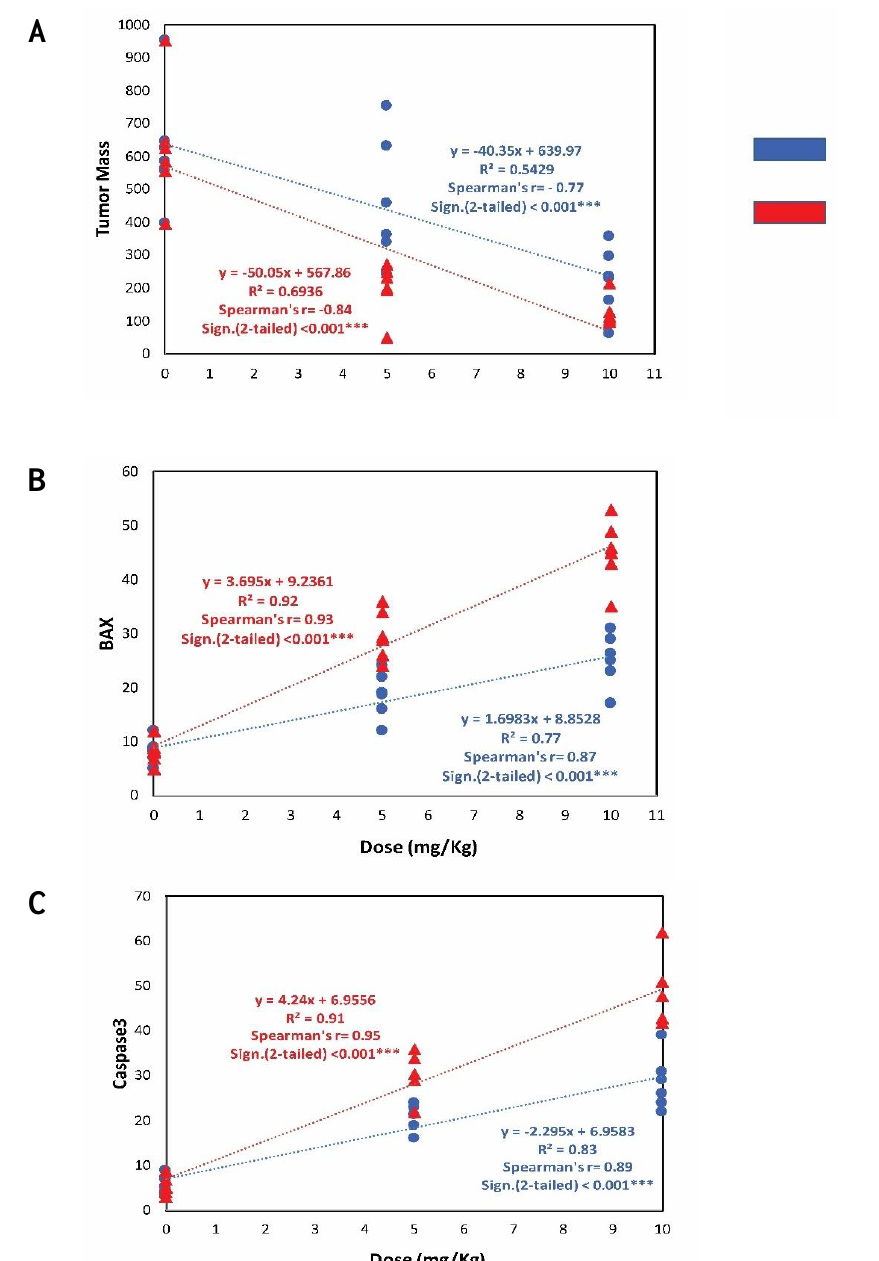
Figure 9. Regression trend-line for correlation between the drug preparations and tumor markers. The relationship between dose (mg/kg) on x axis and tumor mass ( A ), BAX immunostaining area ( B ) and caspase immunostaining area ( C ) on Y axis. r = Spearman’s correlation coefficient, *** P < 0.001, n = 6.